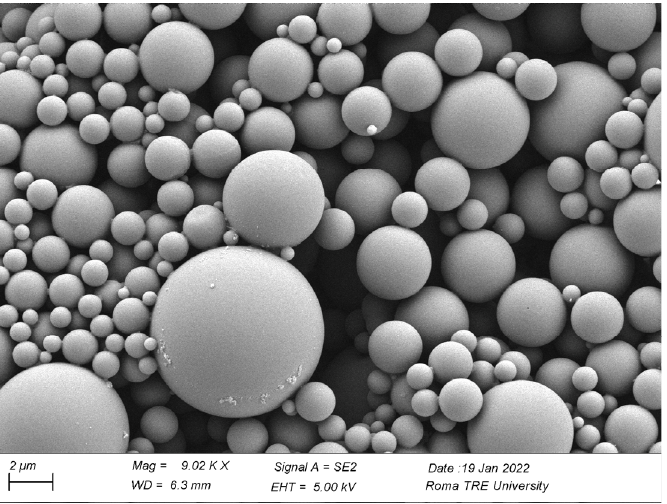
Figure 8. Scanning electron microscope (SEM) image of stock suspension of MP